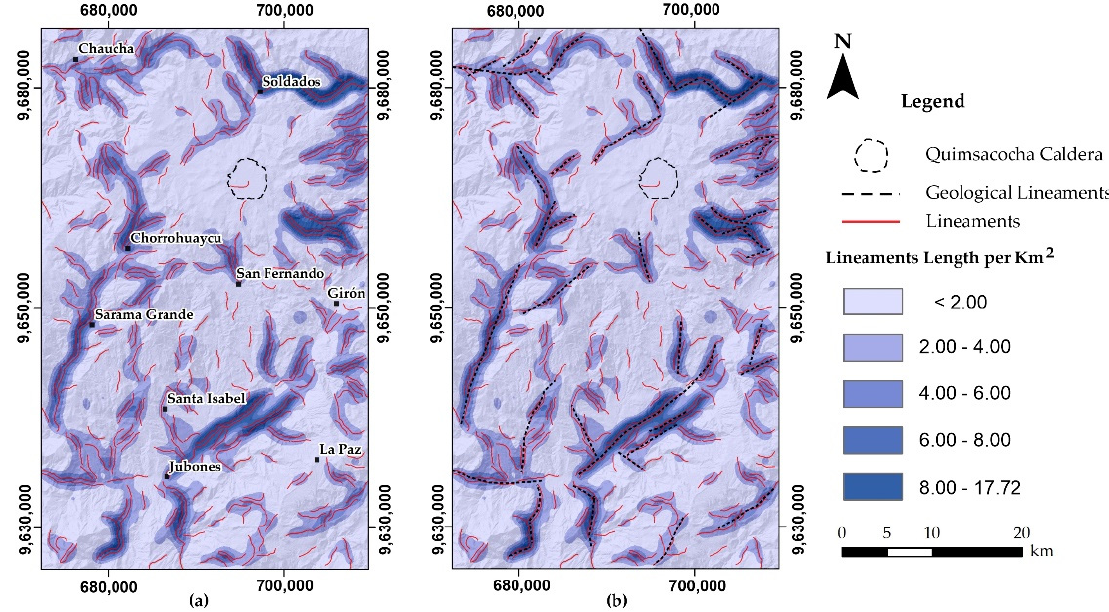
Figure 11 . ( a ) Lineament density map of the automatically extracted lineaments. ( b ) The first delim ‐ delimitation of the geological itation of the geological lineaments . Table 4 . Area of lineament density classes .